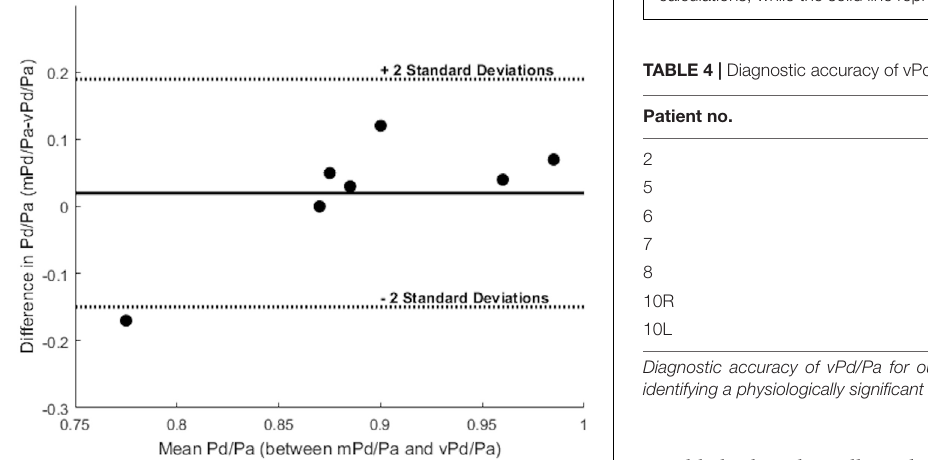
FIGURE 8 | Correlation between mPd/Pa and vPd/Pa. The diagram plots mPd/Pa against vPd/Pa for each stenosis, where the segmented line in gray represents the points of exact agreement between measured and virtual calculations, while the solid line represent the data trendline of best-fit.